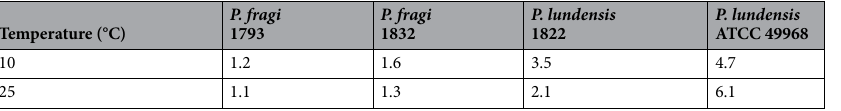
Table 2. Total protein to carbohydrate ratios of the biofilm matrix of the P. fragi and P. lundensis strains grown at 10 °C and 25 °C.